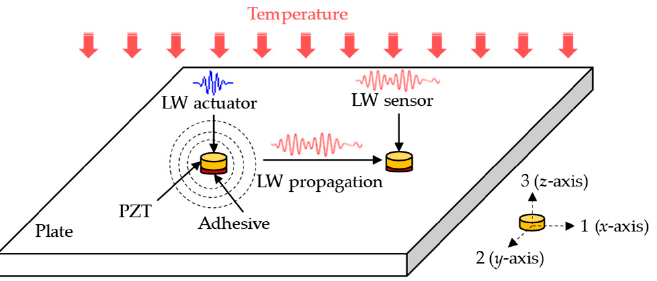
Figure 1. Schematic diagram of LW propagation with the PZTs under temperature